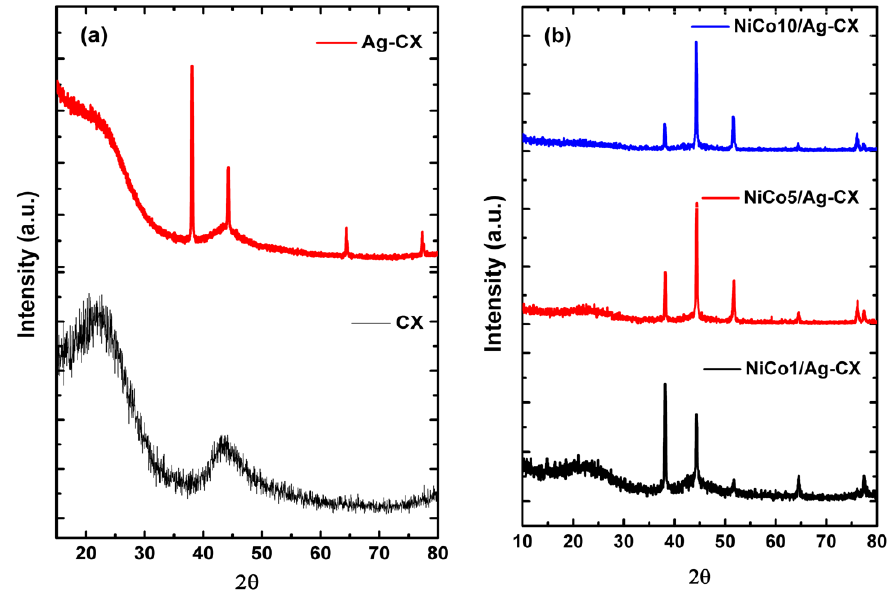
Figure 2. XRD patterns of ( a ) CX and Ag-CX, ( b ) NiCo1/Ag-CX, NiCo5/Ag-CX, and NiCo10/Ag-CX.